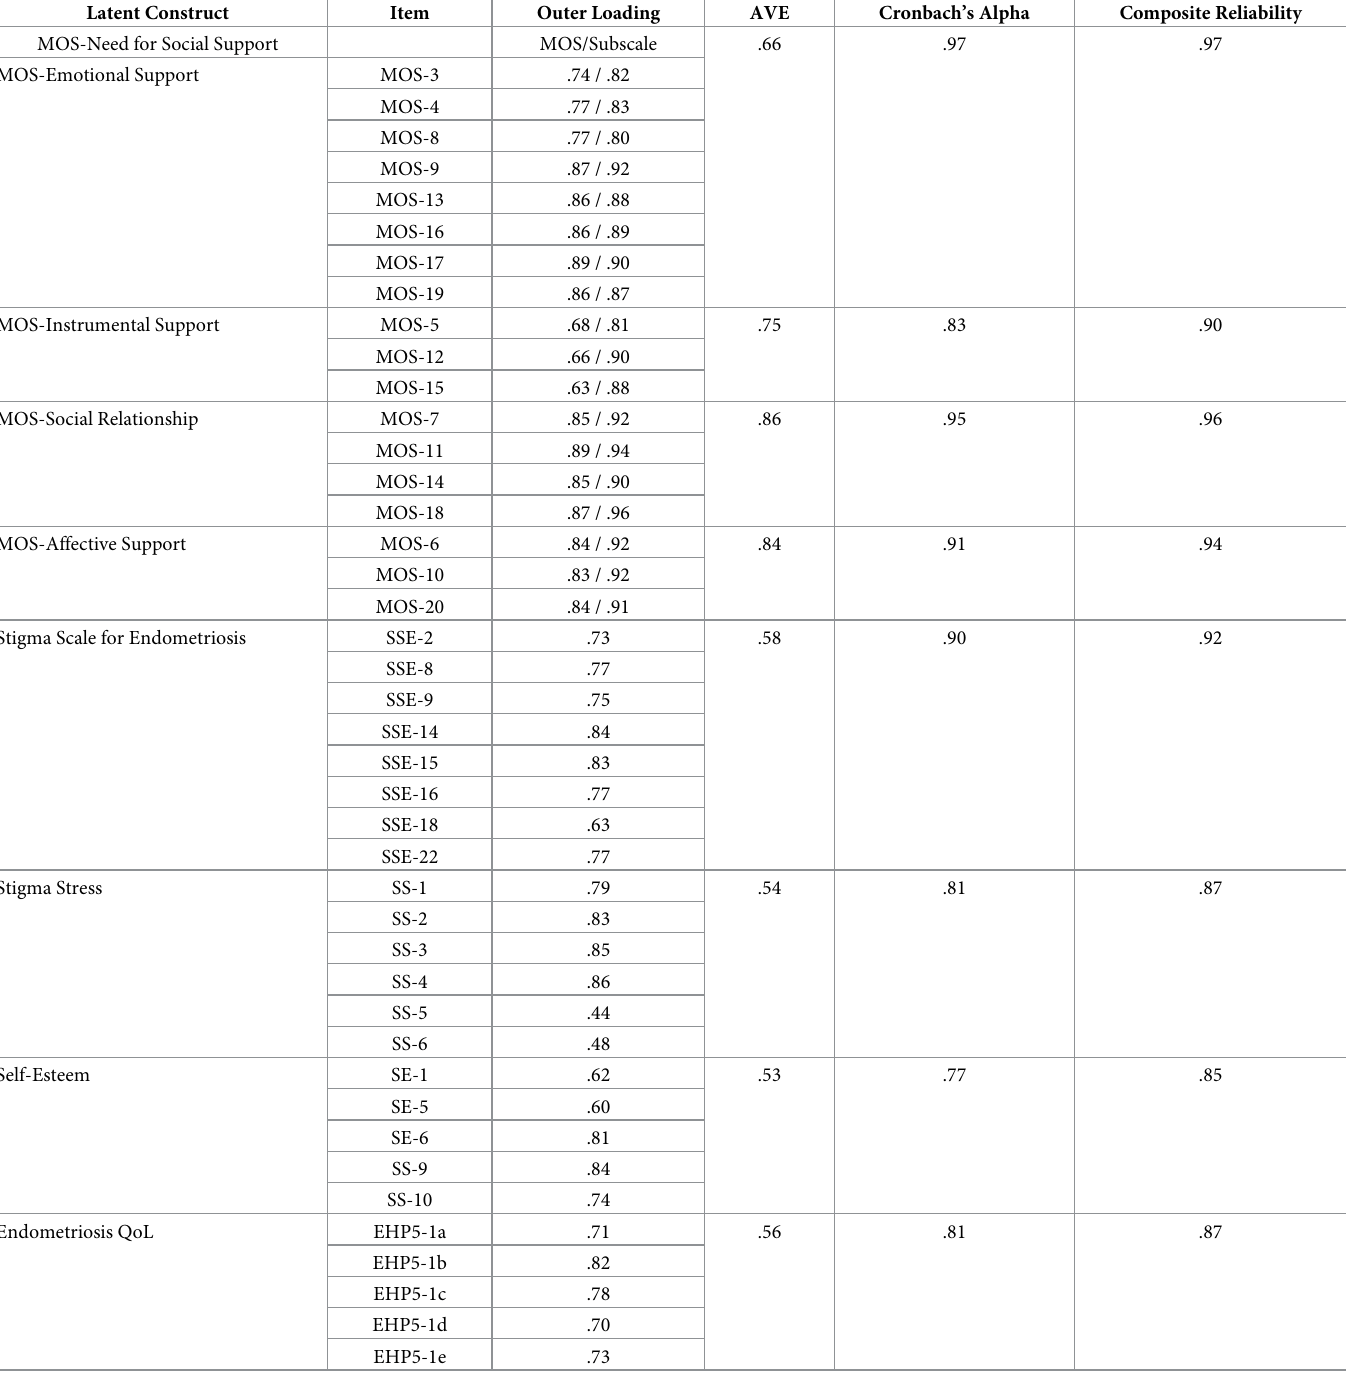
Table 2. Outer loadings, average variance extracted (AVE), and reliability using Cronbach’s alpha and composite reliability. Latent